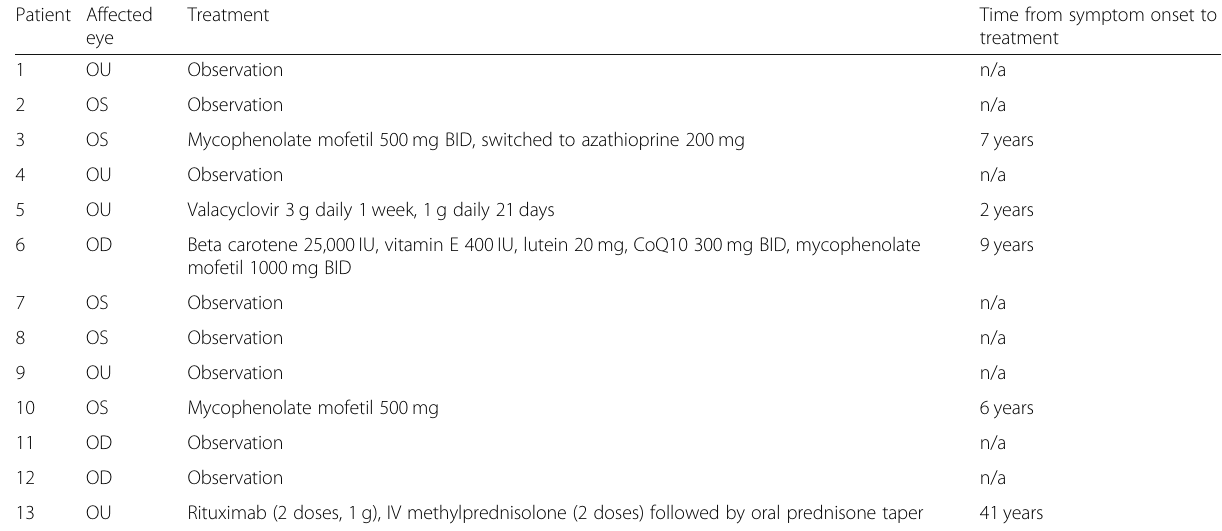
Table 5 Treatment regimens for all 13 patients with npAIR with time of symptom onset to initiation of treatments Patient Affected Treatment Time from symptom onset to eye